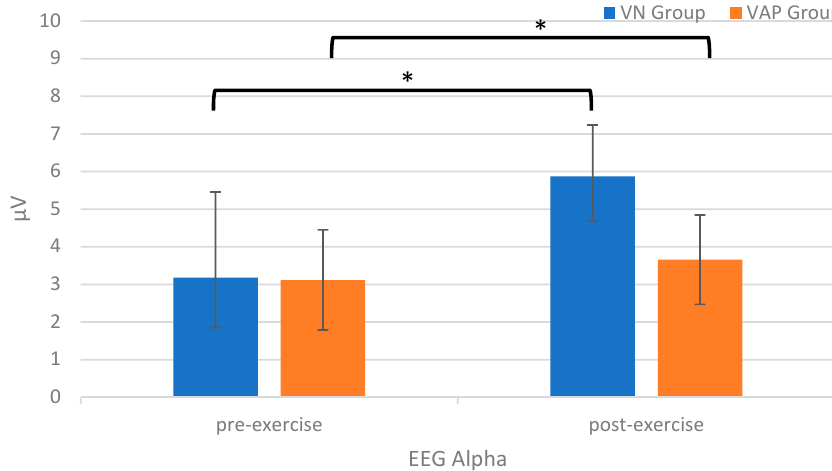
Figure 3. EEG alpha values ( μ V) for the virtual nature (VN) and the virtual abstract painting (VAP) groups before and after the exercise intervention (* p < 0.05).